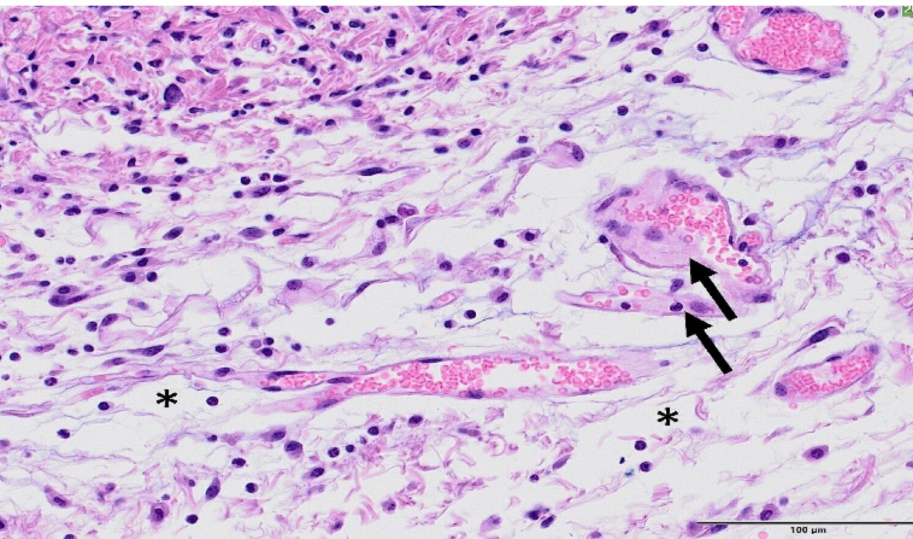
Figure 12. Broad beam irradiation. HE staining, Bar = 100 µ m. Within the dermis, there is an inflammatory infiltrate consisting of macrophages, lymphocytes, and neutrophils. The collagen fibres from the connective tissue were separated by oedema (white spaces, asterisk). In the image, a couple of vessels present early hyalinization